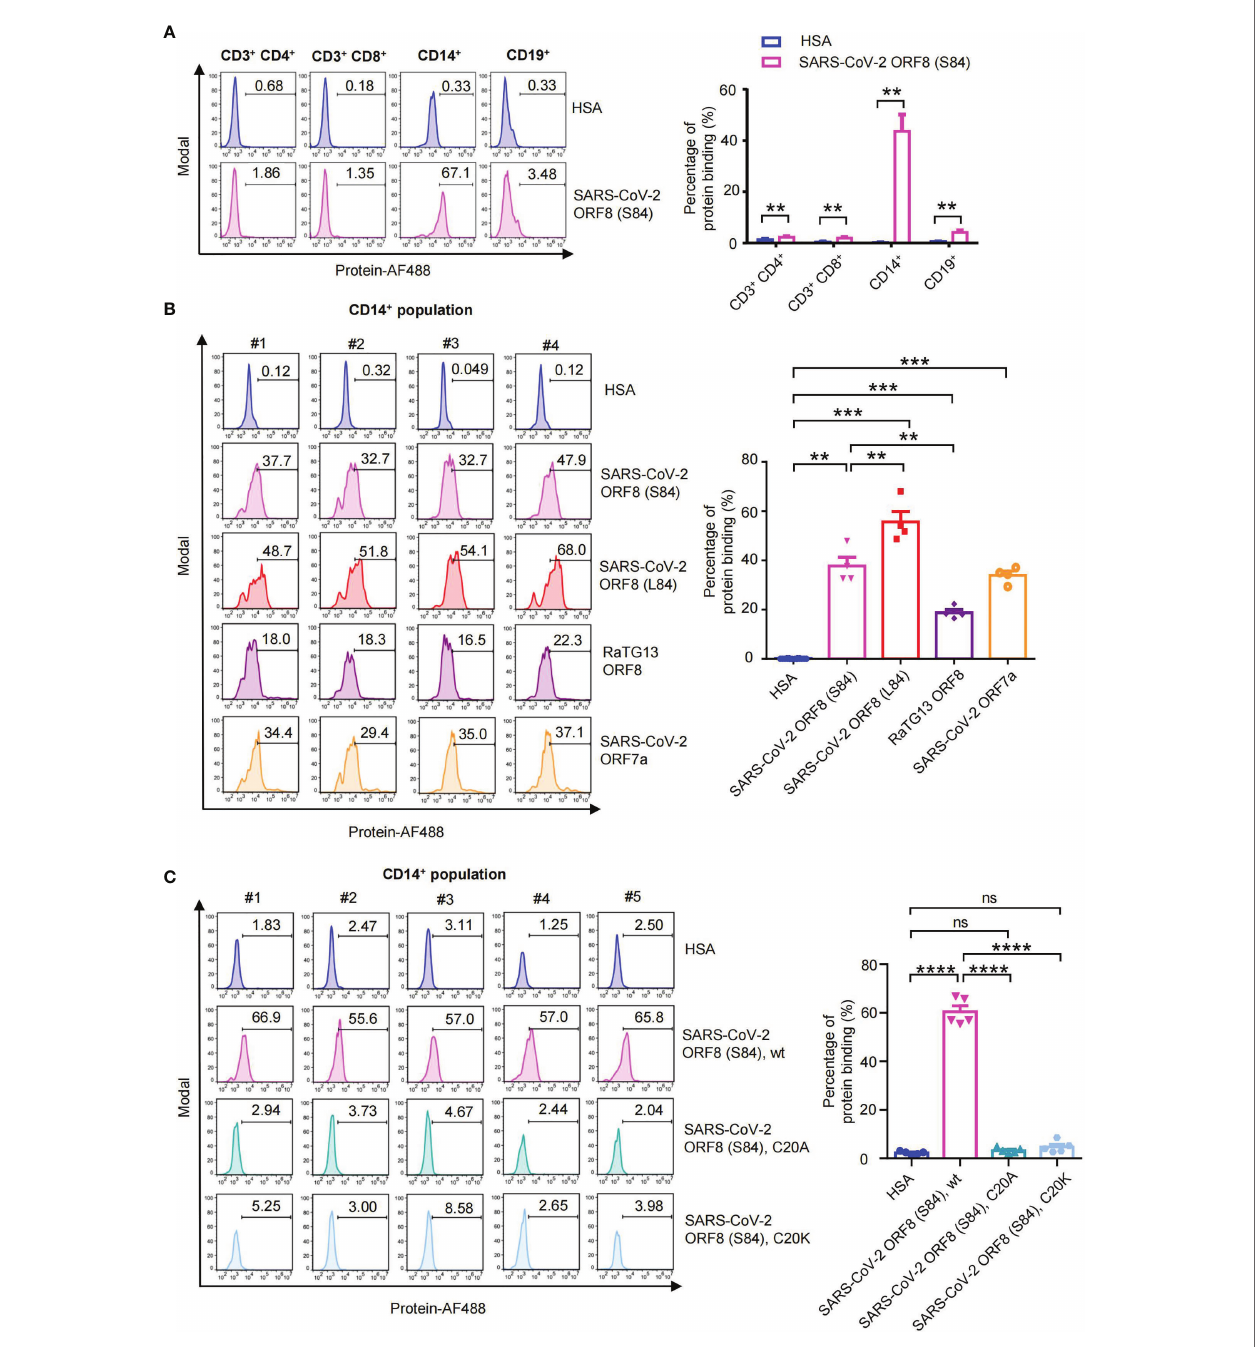
FIGURE 4 | Human PBMC binding assay of SARS-CoV-2 Ig-like domain protein. (A) Alexa Fluor 488-coupled SARS-CoV-2 ORF8 (S84) incubated with human PBMCs from healthy donors (n = 5), and the binding abilities to CD3 + CD4 + T cells, CD3 + CD8 + T cells, CD14 + monocytes and CD19 + B cells were analyzed via fl ow cytometry. Representative fl ow cytometry plots (left) and statistical analysis (n=5) (right) are present. (B) Alexa Fluor 488-coupled proteins incubated with human PBMCs from healthy donors (n = 4), and their binding abilities to CD14 + monocytes were analyzed via fl ow cytometry. Human serum albumin (HSA), SARS-CoV-2 ORF8 (L84), SARS-CoV-2 ORF8 (S84), Bat coronavirus RaTG13 ORF8, SARS-CoV-2 ORF7a are present. (C) Alexa Fluor 488-coupled proteins incubated with human PBMCs from healthy donors (n = 5), and their binding abilities to CD14 + monocytes were analyzed via fl ow cytometry. Human serum albumin (HSA), SARS- CoV-2 ORF8 (S84), and its C20A, C20K mutant protein are present. Data were analyzed using paired two-tailed Student ’ s t-tests, and the error bars show the means ± SEM ( **P < 0.01; ***P < 0.001; ****P < 0.0001; ns, nonsigni fi